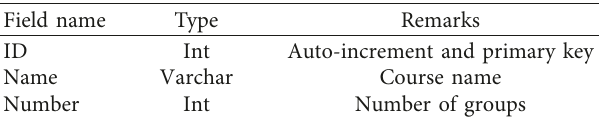
Table 4: Group table.